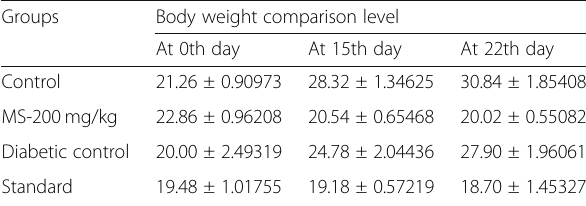
Table 1 Effects of EMSL on body weight in alloxan induced diabetic nephropathy mice Groups